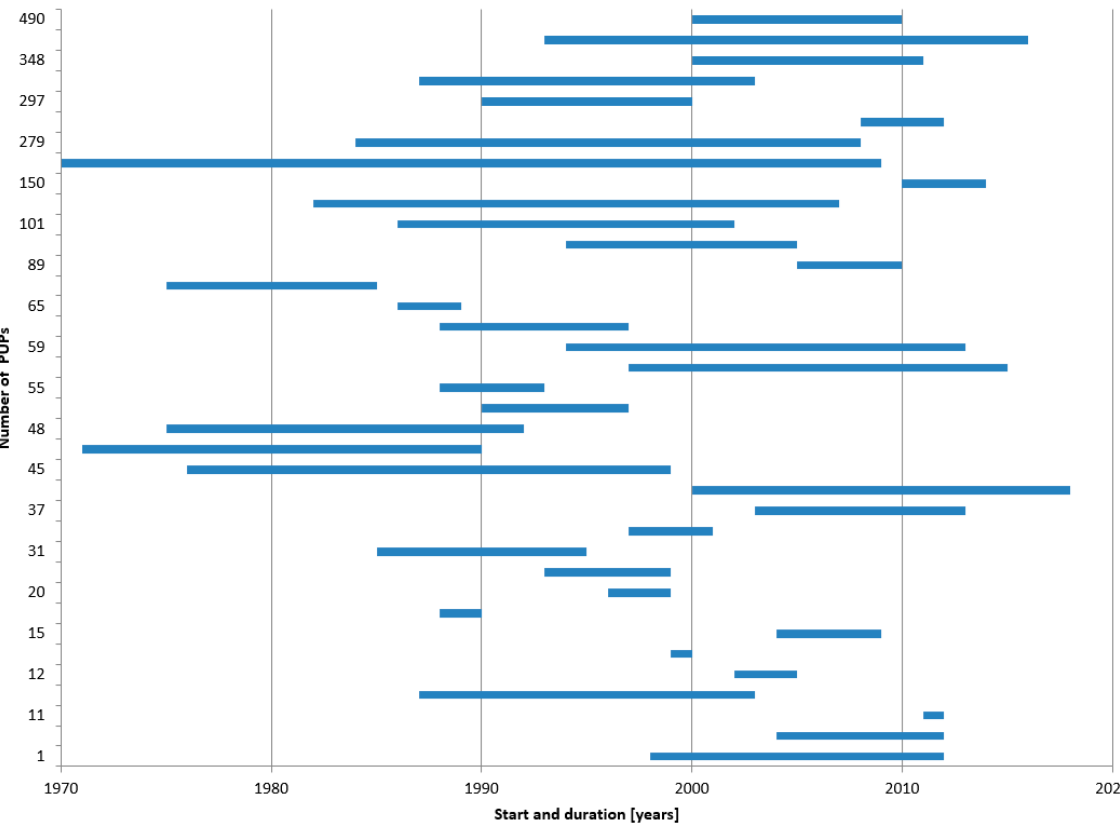
Figure 5. Previously untreated patients (PUP) studies—Number of patients, study start and study duration. Shown are 37 of the 38 publications (for one, the duration could not be found) with the number of recruited patients, the year of study start, and study duration. The publications and underlying data can be found in the Supplement to this paper (File S4).